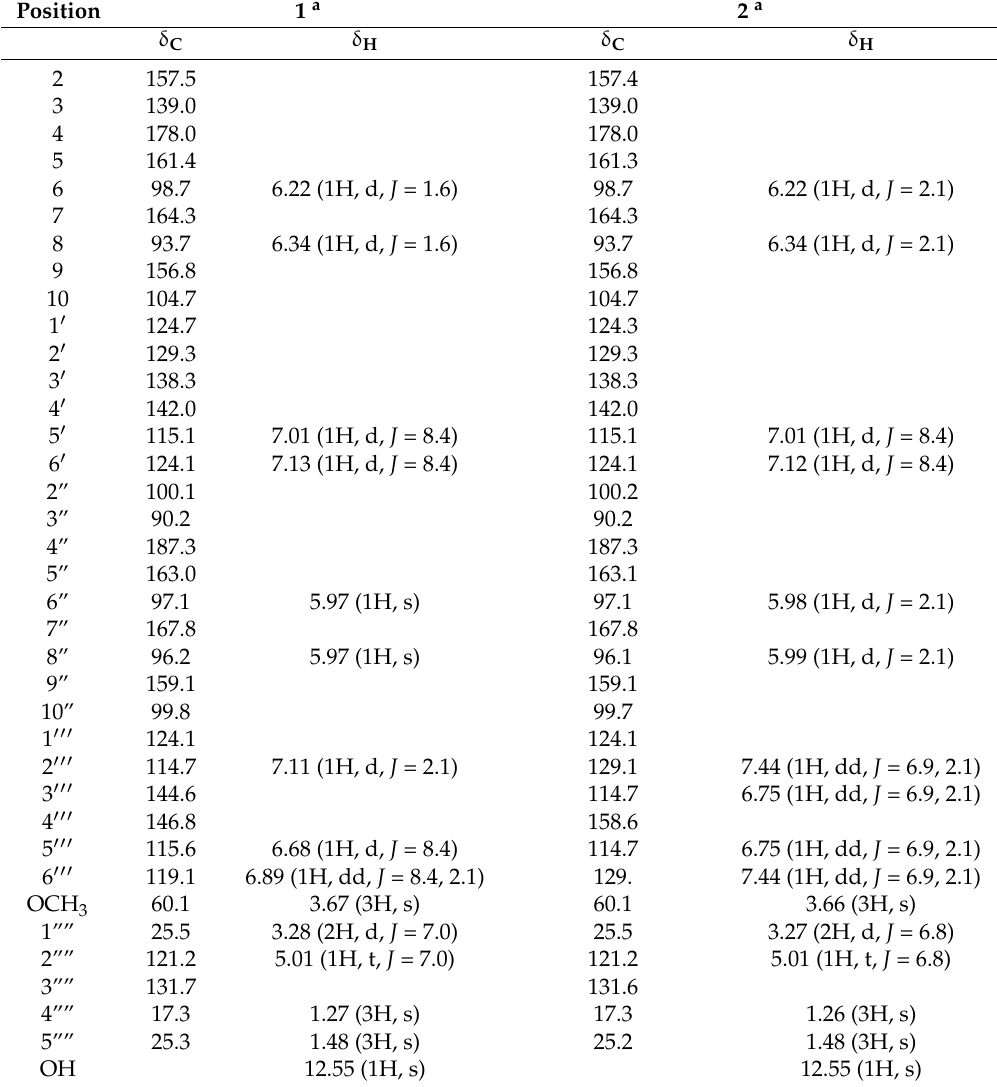
Table 2. 1 H-NMR and 13 C-NMR spectroscopic data for compounds 1 – 2